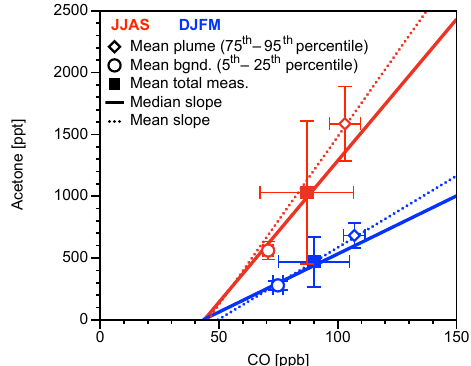
Figure 6. Comparison of (a) the mean literature values for biomass burning plumes and for plumes of other origin with the distribu- tion of EnR observed with CARIBIC in the Northern Hemisphere subtropics and mid-latitudes (23.5–66.5 ◦ N) in (b) winter (DJFM) and (c) summer (JJAS). The grey lines represent Gaussian curves fitted to the histograms. The values of the most important statistical variables describing the distributions are given in Table 6.